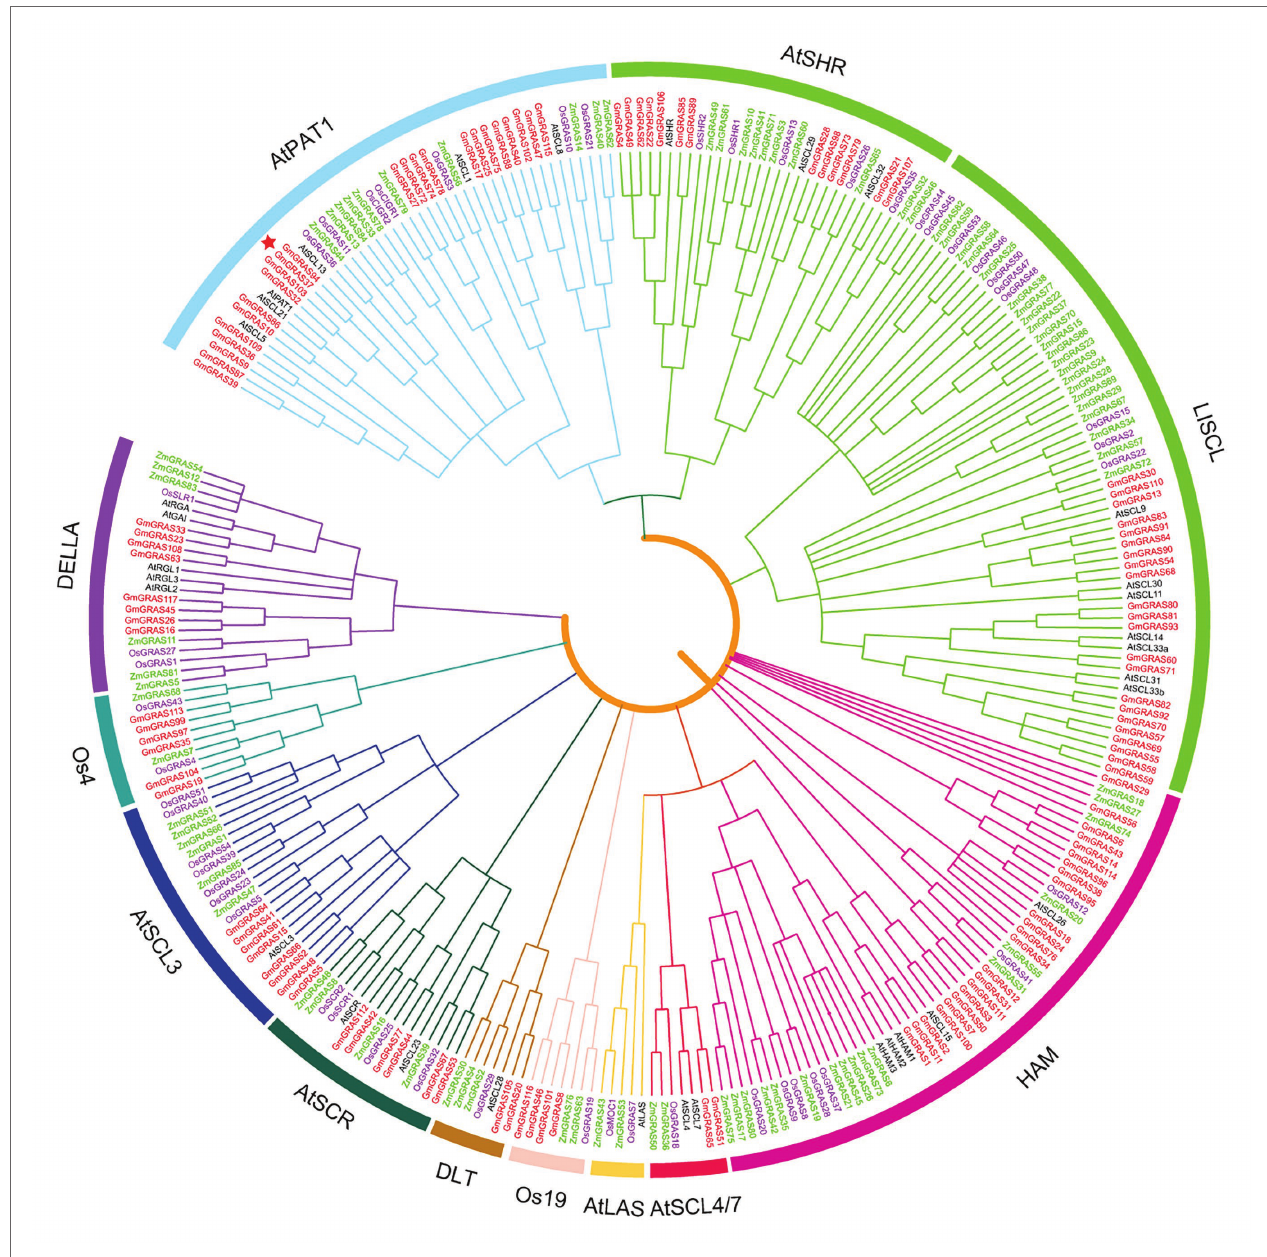
detected; these segmental duplicates were found on all 20 chromosomes. ( Figure 6 and Supplementary Table S2 ). The results showed that gene segmental duplication events may have been the main driving force behind GRAS gene evolution in soybean. We estimated the synonymous (Ks) and nonsynonymous (Ka) substitution rates (Ka/Ks) of 61 segmentally duplicated pairs ( Figure 7 and Supplementary Table S2 ). The Ka/Ks ratios for segmentally duplicated gene pairs ranged from